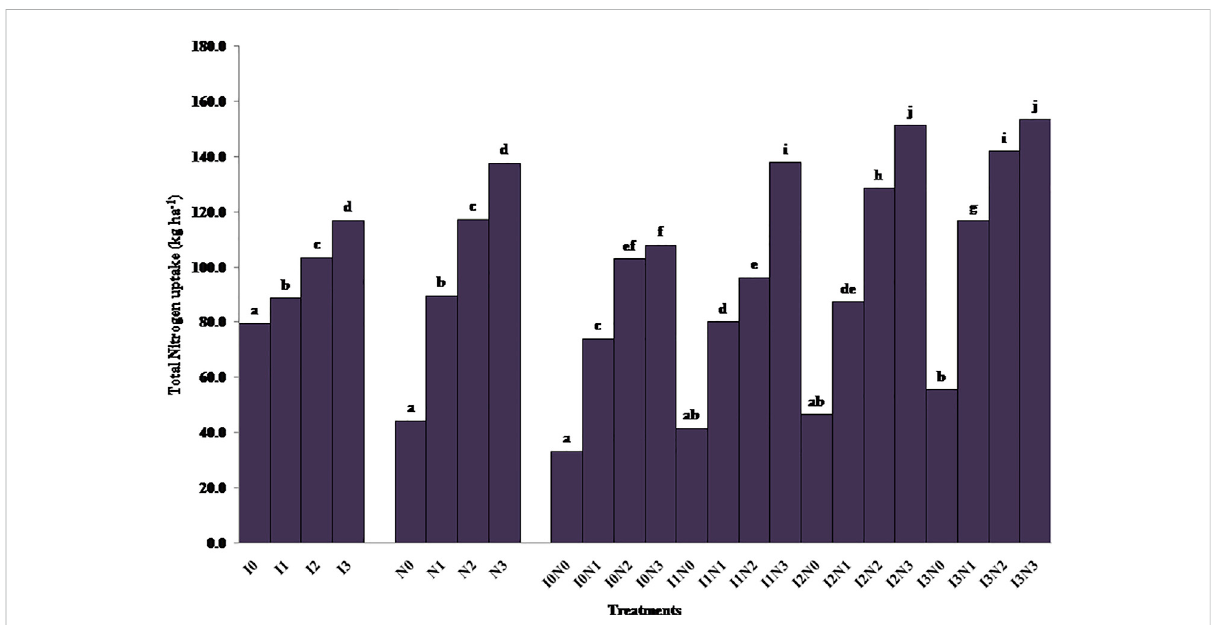
FIGURE 5 Effect of irrigation and nitrogen levels and total nitrogen uptake under zero-tilled wheat crop of theTerai agro-ecological zone in eastern India (pooled analysis) (means of similar lowercase letters are not signi fi cant at p < 0.05 based on DMRT).